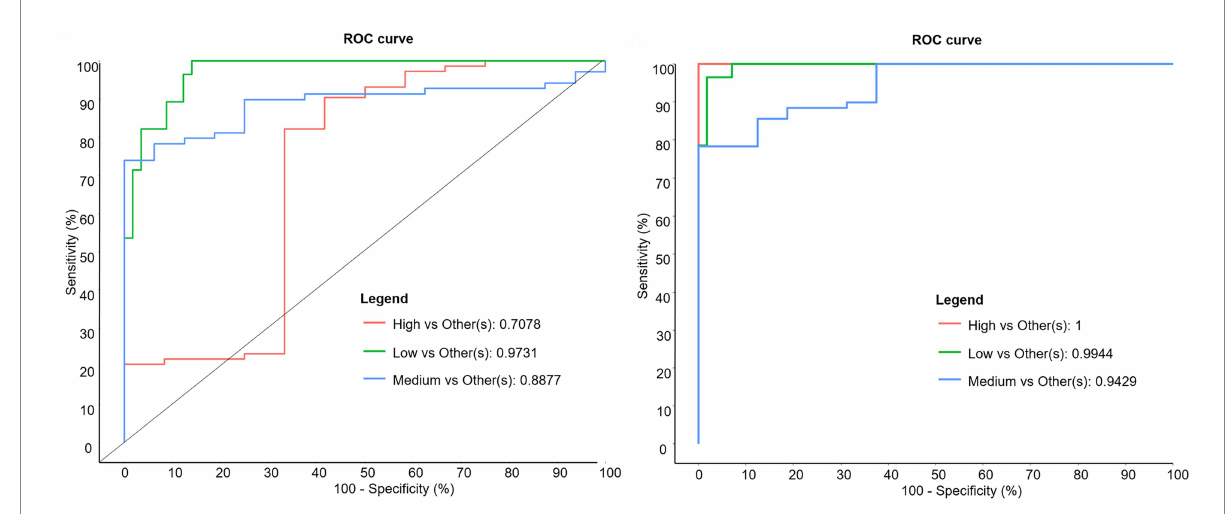
FIGURE 6 Receiving operator characteristic curves discriminating between trans -10/ trans -11 ratio classes at genus (left) and OTU (right) levels.